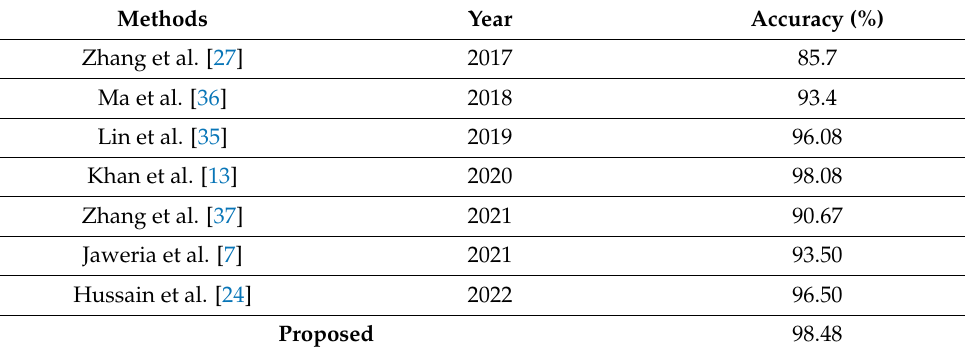
Table 10. Comparison with SOTA for cucumber leaf diseases